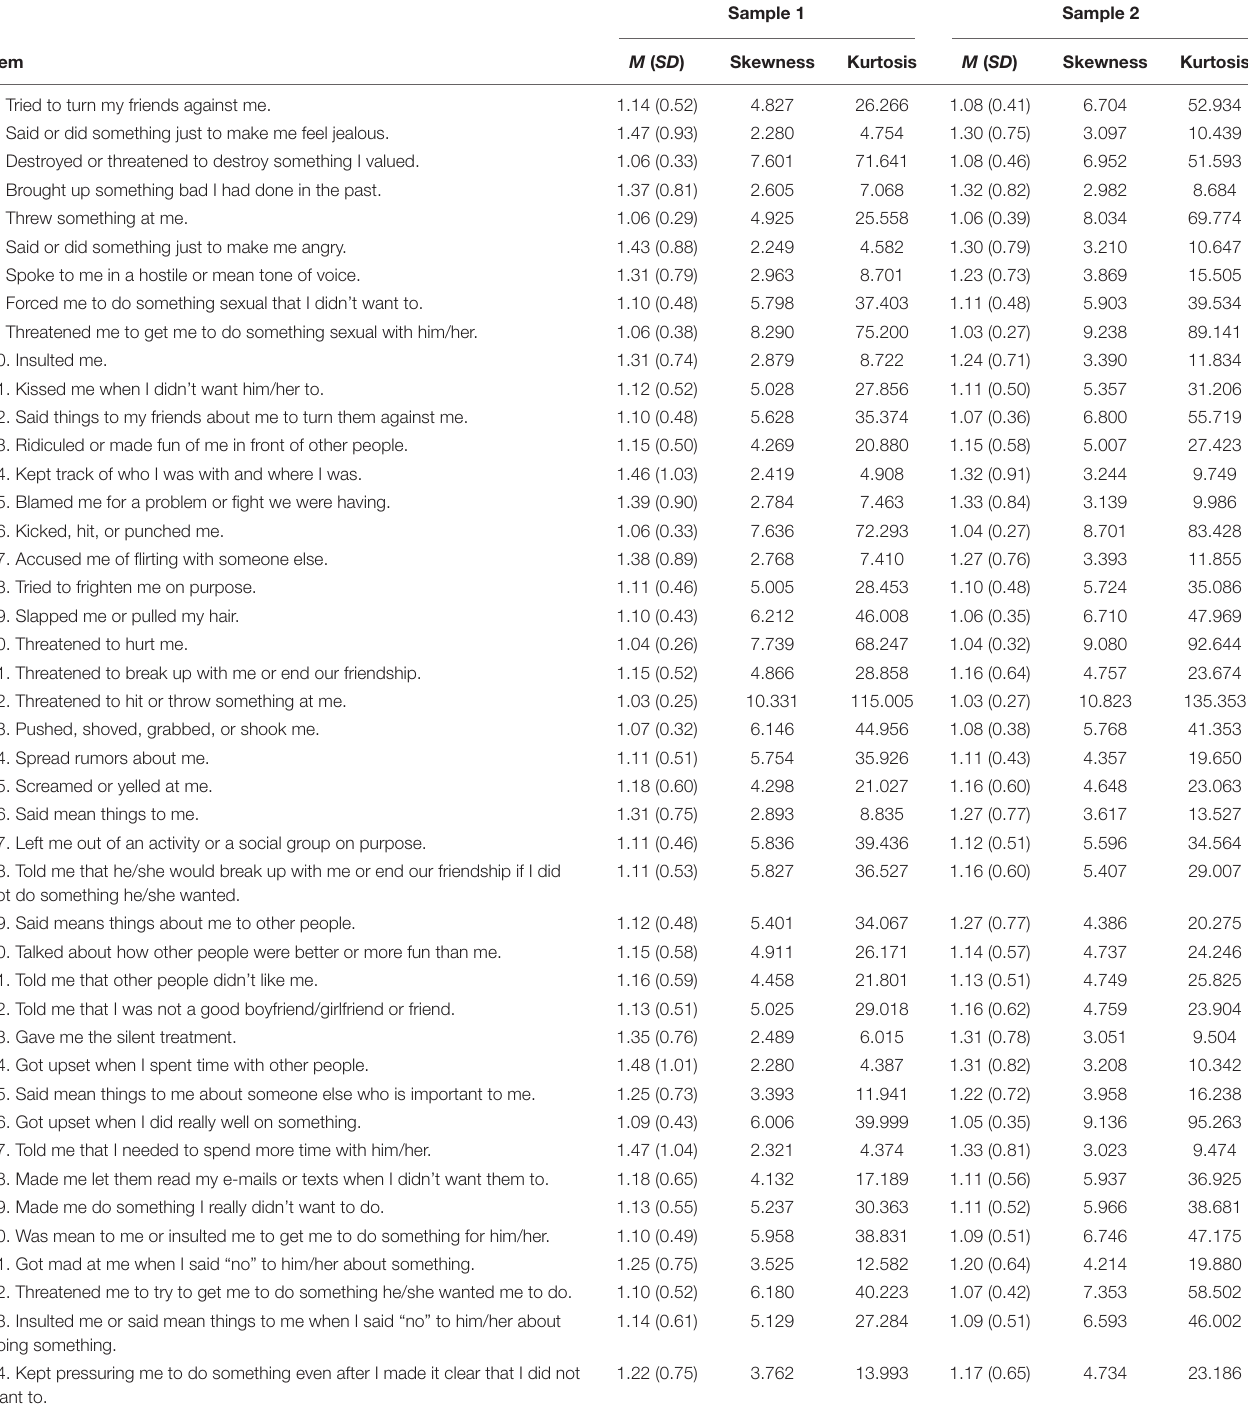
TABLE 2 | Descriptive statistics of items.